Question: Which kind of chart has been used to present this data?
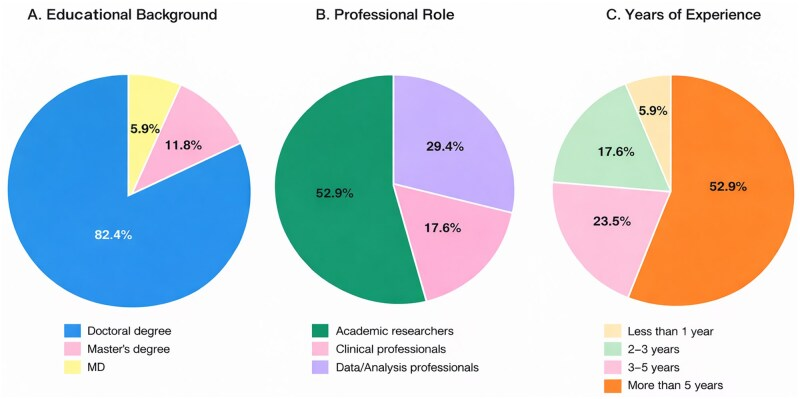
Answer: pie